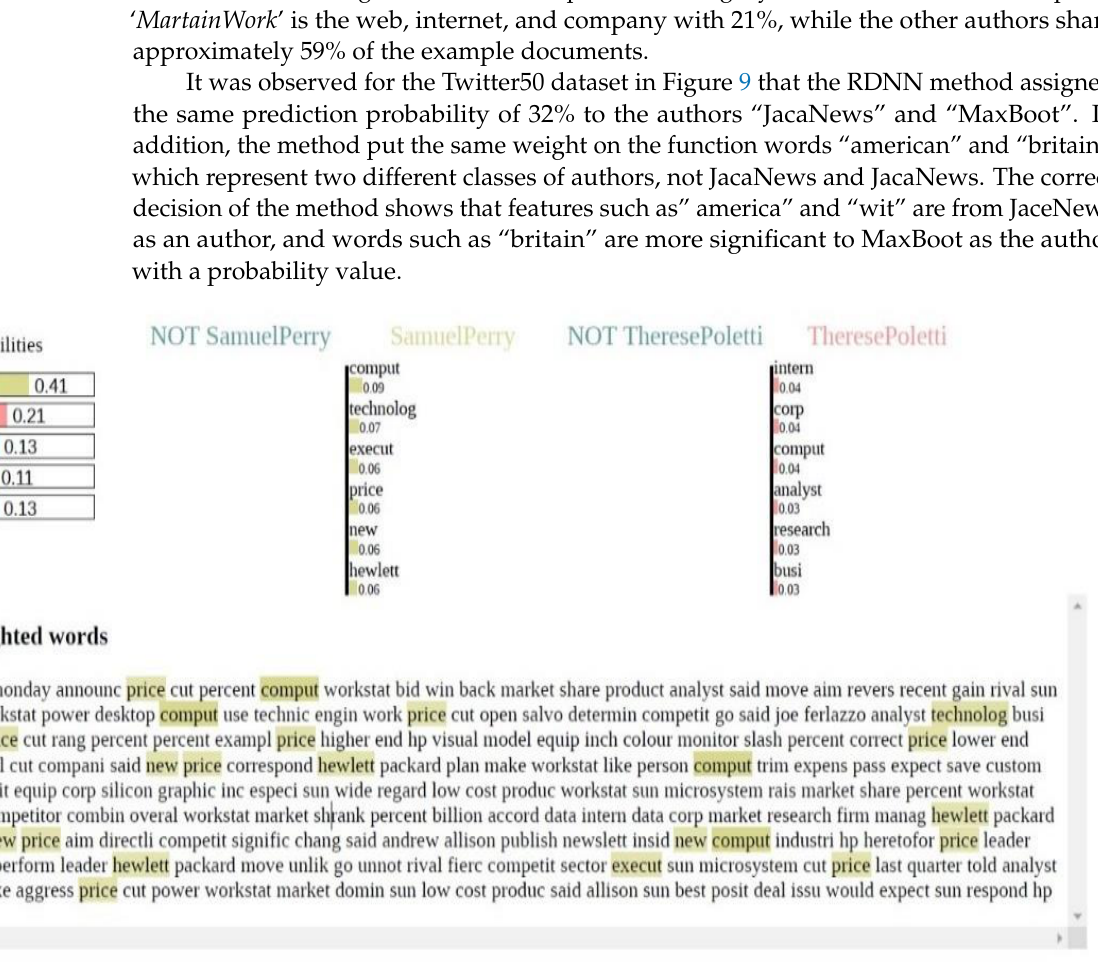
Figure 7. Explanation of individual prediction of the proposed method on the CCAT50 document using LIME.